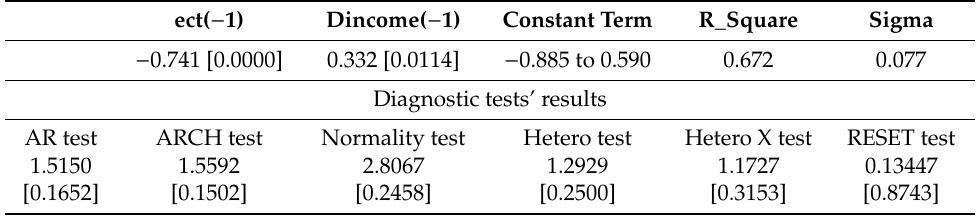
Table 9. MIS short-run estimation